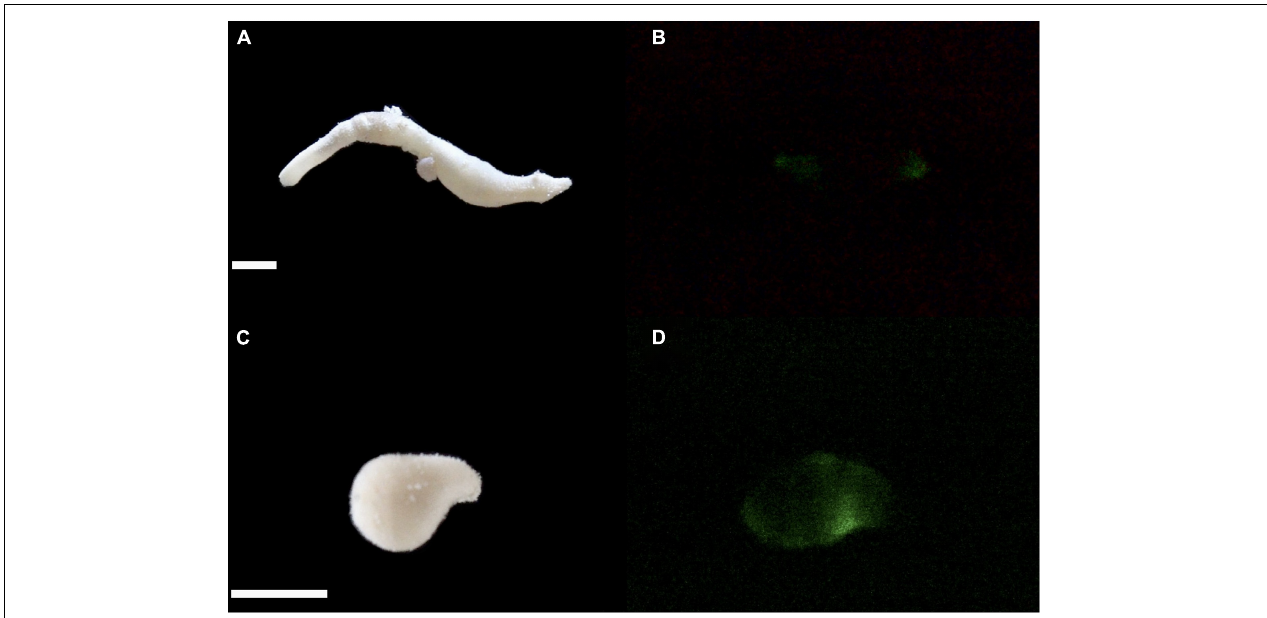
FIGURE 1 | Images of N. pellucidum with introvert everted (A) , retracted (C) and in the dark displaying bioluminescence by mechanical stimulation (B,D) . Scale bars = 0.5 cm. Photos: Oliveira G. Anderson. Images were processed using Adobe Premiere Pro 2019.